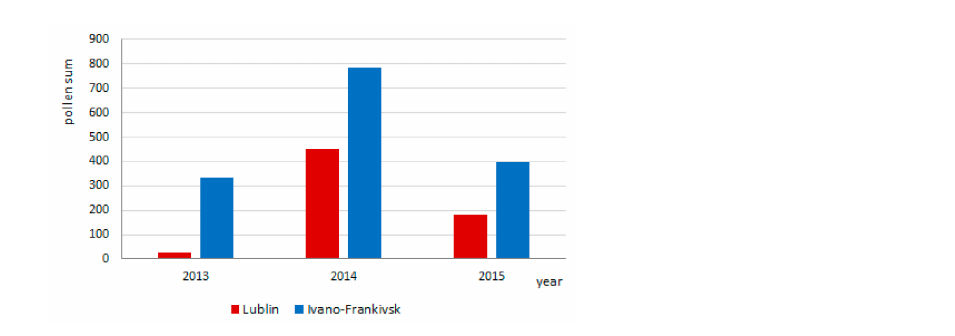
Figure 4. Comparison of annual pollen sums for Ambrosia in the air of Lublin and Ivano-Frankivsk, 2013–2015.